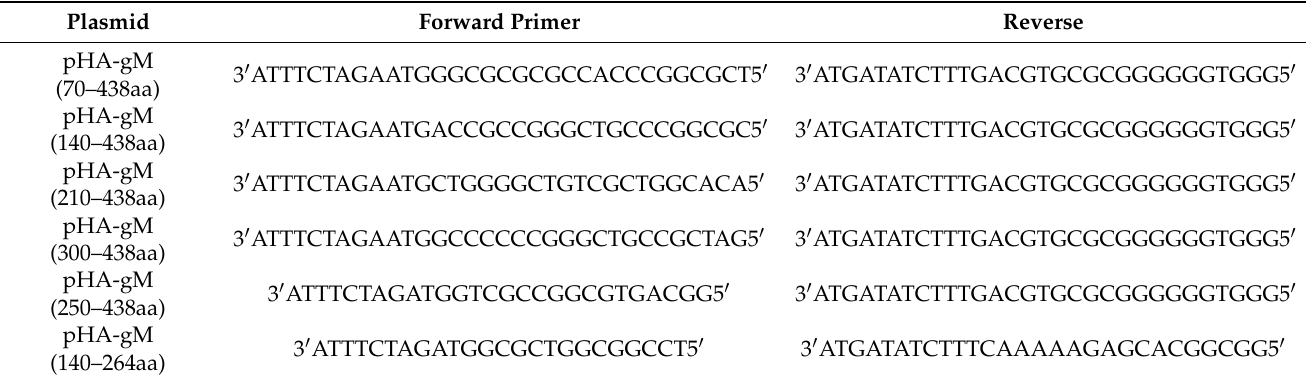
Table 1. Primer list for construction of plasmids encoding HA-tagged truncated gM versions. Plasmid Forward